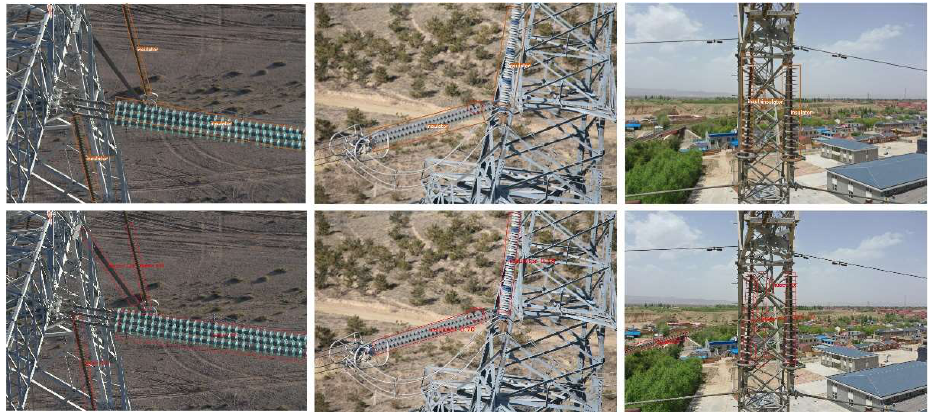
Figure 7. Comparison of the detection results of our model and SCRDet++.